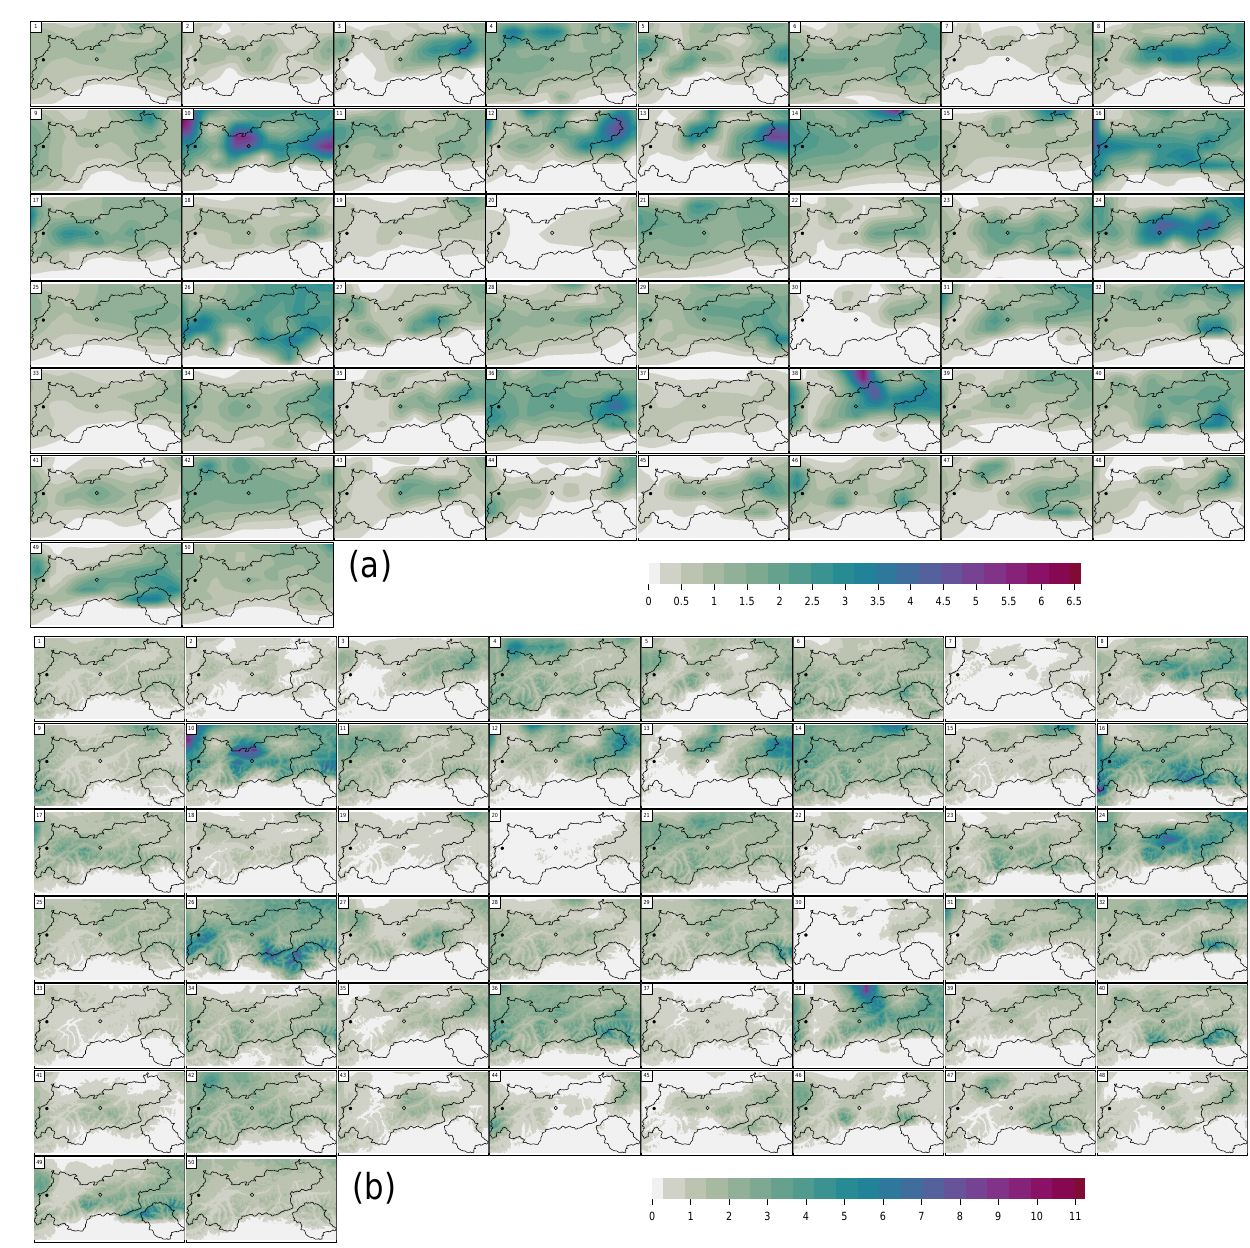
Figure B2. Stamps for + 48h forecasts initialized 8 March 2017 00:00UTC (valid for 10 March 2017 00:00UTC). Individual EPS members for 1h precipitation sums (a) and the corresponding copula members (b) . Please note that the color scale for all members of one type (EPS/copula) is identical, but the scales between the raw EPS and the results from the postprocessing